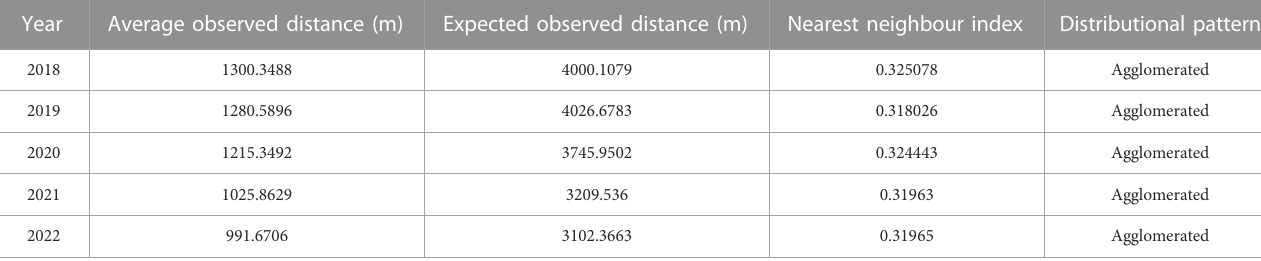
TABLE 1 Nearest neighbor index of water pollution enterprises in Zhejiang Province from 2018 to